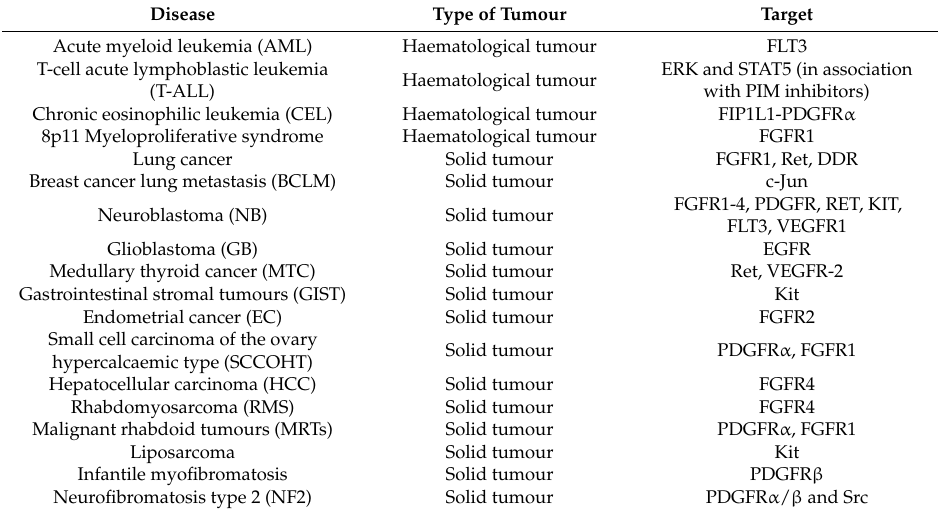
Table 1. Haematological and solid tumours on which ponatinib has been tested and targeted kinase(s). Disease Type of